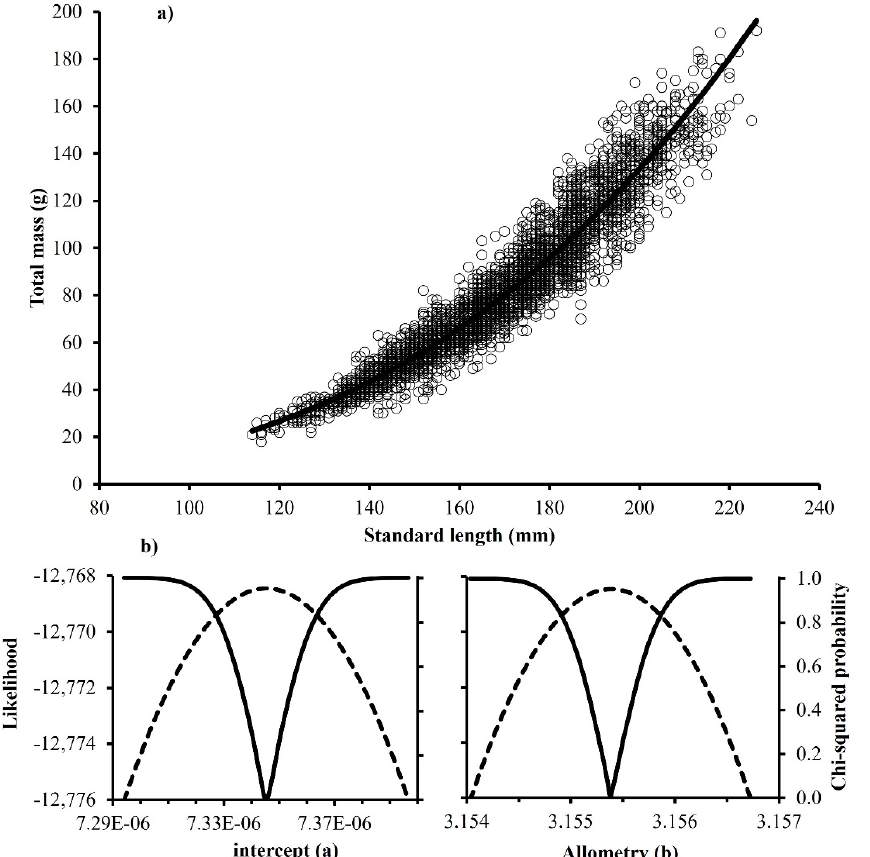
Figure 3. ( a ) Total body mass and standard length ( TM – SL ) relationship for the Sardinops sagax temperate stock in the southern California Current System (CCS); ( b ) likelihood profiles for parameters a and b obtained for the TM – SL relationship. Table 2. Average values and 95% confidence intervals (CI; α = 0.05) of parameters a and b obtained by adjusting the potential model for each year from 2005 to 2014, including all data (average) of the temperate Sardinops sagax stock and growth type (GT; +H, hyper-allometry; − H, hypo-allometry).